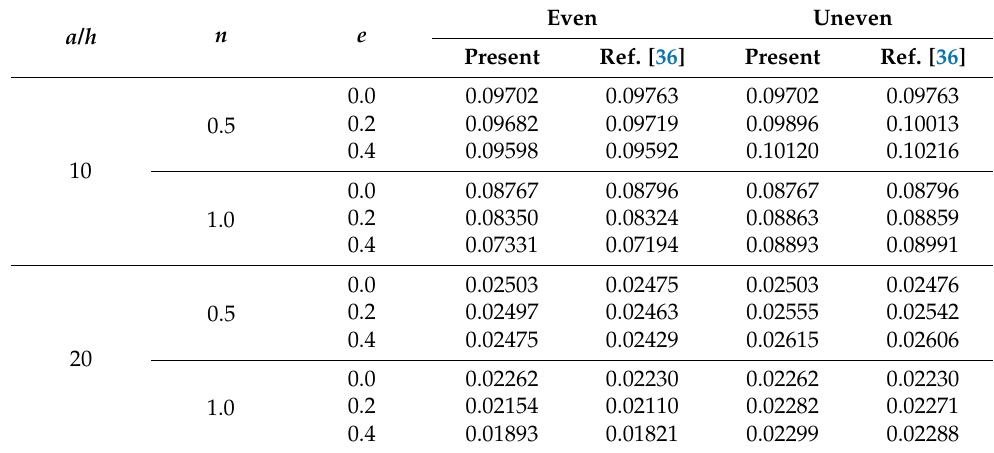
Table 3. The calibrated fundamental frequencies ω ( 1,1 ) of simply supported square FG porous plate. Even Uneven a/h n e Present Ref. [36] Present Ref.